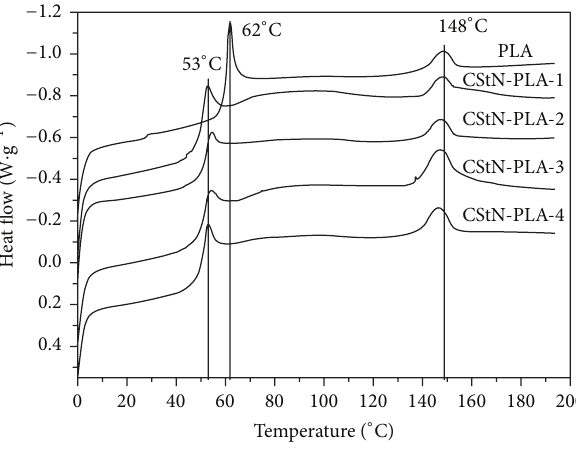
Figure 4: Mechanical properties of CStN/PLA nanocomposites.